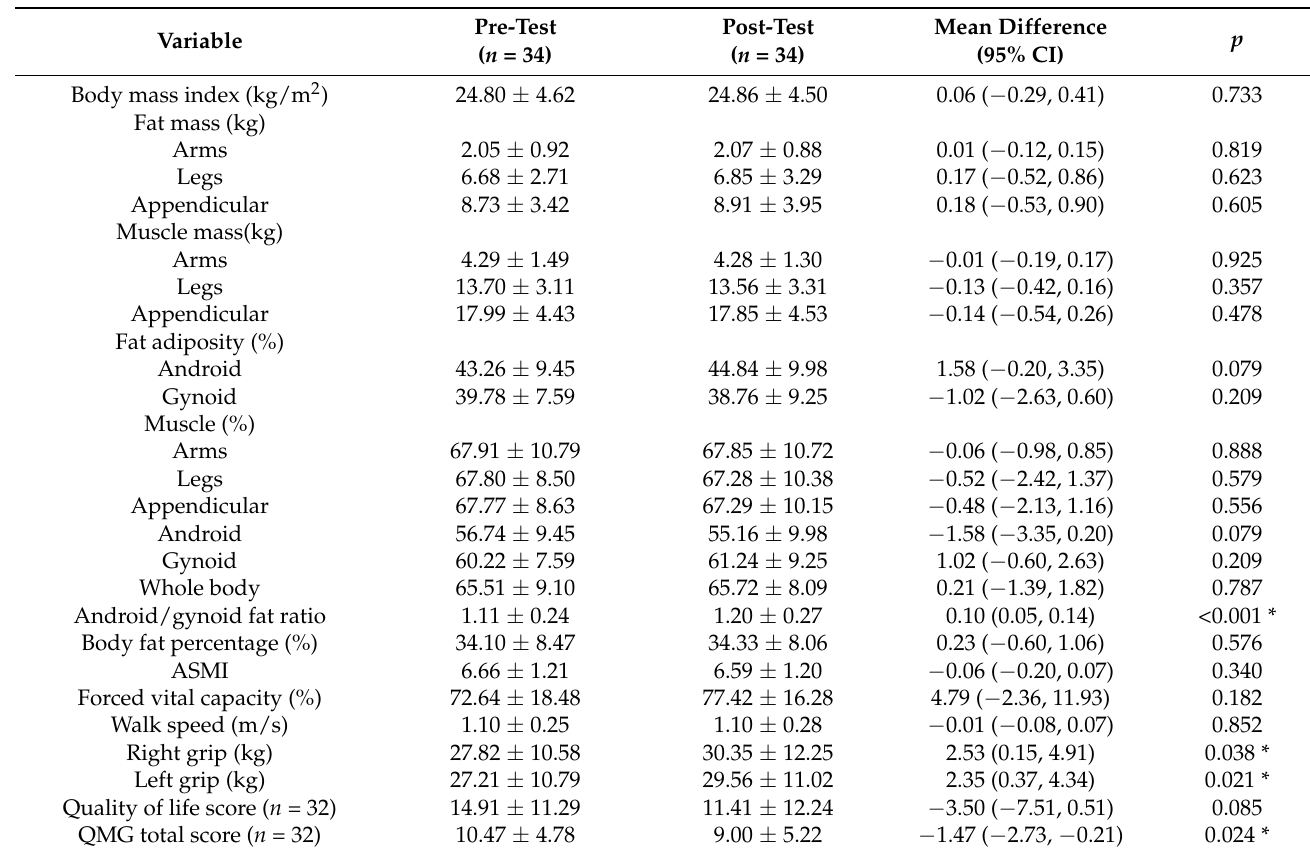
Table 2. Body composition of patients with MG before and after resistance training ( n = 34).